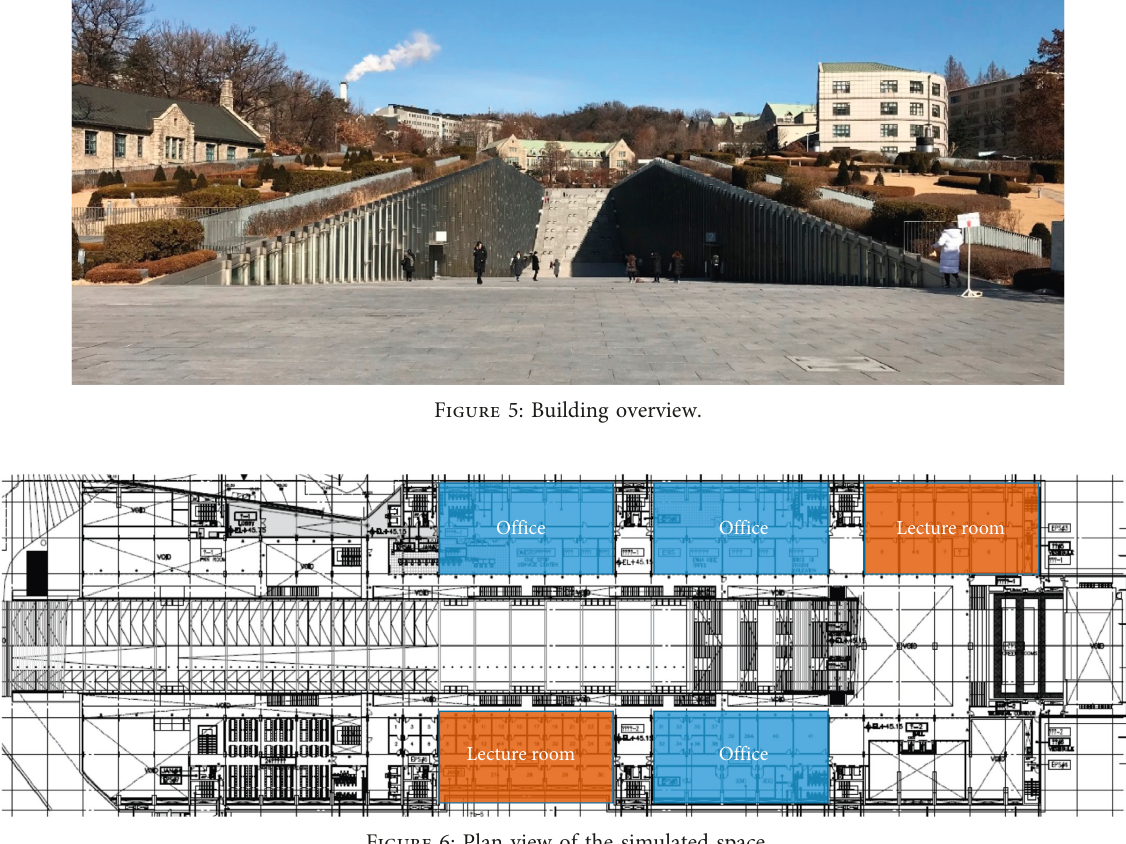
Figure 6: Plan view of the simulated space.